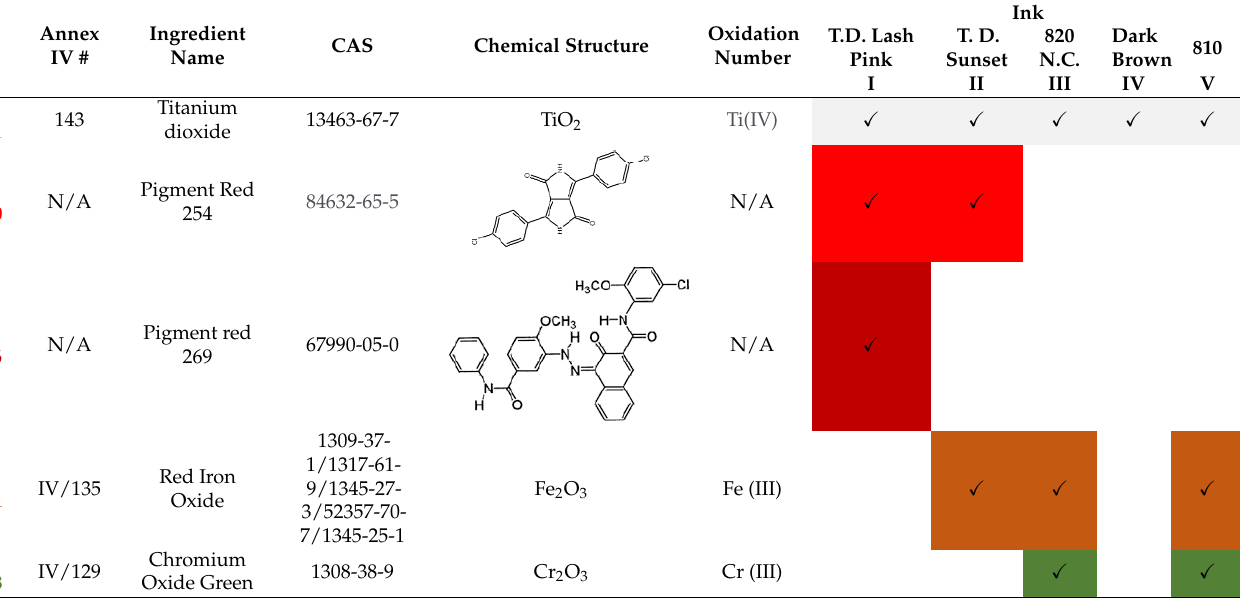
Table 1. Colorant ingredients of the tested PMU inks.